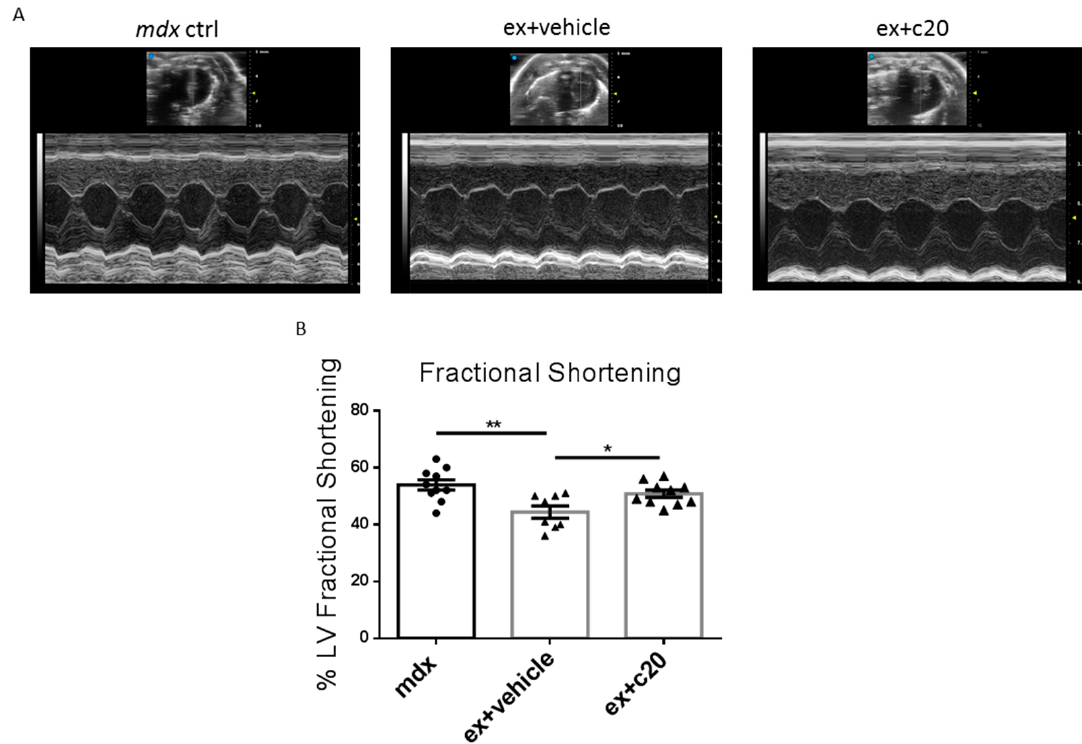
Figure 6. Prevented left ventricular loss of function in C20 treated ex mdx . ( A ) Representative images of the echocardiographic analysis of control mdx and vehicle or C20-treated ex mdx . ( B ) Left ventricle fractional shortening expressed in percentage and calculated on the short axe. n = 10, 8, 10 independent samples per group. * p < 0.05, ** p < 0.01, one-way ordinary ANOVA with Bonferroni correction for multiple comparisons.